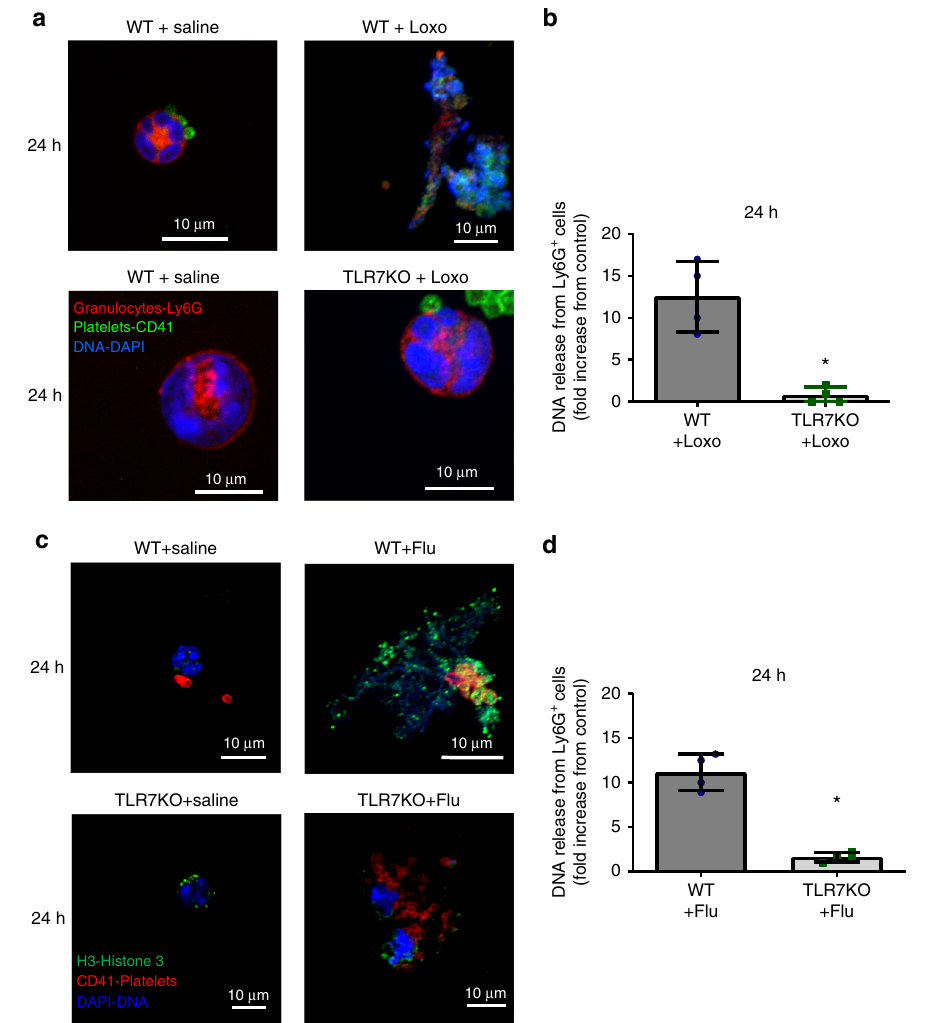
Fig. 9 TLR7 stimulation in vivo leads to DNA release from Ly6G positive cells. WT and TLR7 KO mice were injected intraperitoneally with a TLR7 agonist, or were intranasally infected with in fl uenza (PR8 strain, 40,000 pfu in 30 µ L). Blood was collected by cardiac puncture at 24 h and immediately fi xed (red blood cells were lysed at the same time); Ly6G is predominantly expressed by murine neutrophils. a Representative images of DNA release from Ly6G- positive cells (at 24 h post-Loxo stimulation) resolved by confocal microscopy. b Quantitation of DNA release from Ly6G-positive cells in blood of mice ( n = 4/group) at 24 h after agonist stimulation ( p = 0.016, df = 6). c Representative images of DNA release (at 24 h post in fl uenza infection) resolved by confocal microscopy. Pictures showing Ly6G-highly positive origin of the released DNA are included in Supplementary Fig. 11. d Quantitation of the DNA release from Ly6G-positive cells in blood of mice ( n = 4/group) at 24 h post-infection ( p < 0.001, df = 6). In all cases, the bar represents 10 μ m and values in the bar graphs represent the average ± SD; star symbol (*) indicates p < 0.05. Signi fi cance was assessed by unpaired t -test (two-tail value). Source data are provided as a Source Data fi